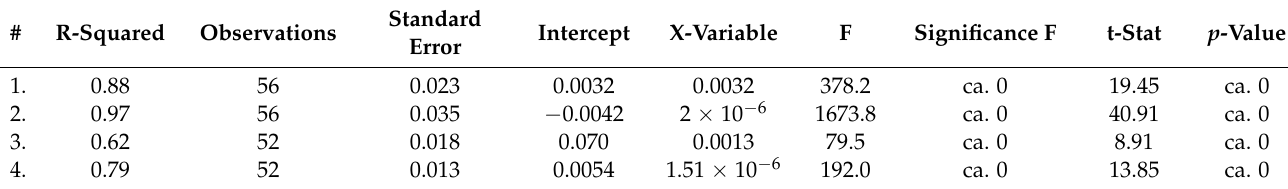
Table 5. Summary of regression analysis.